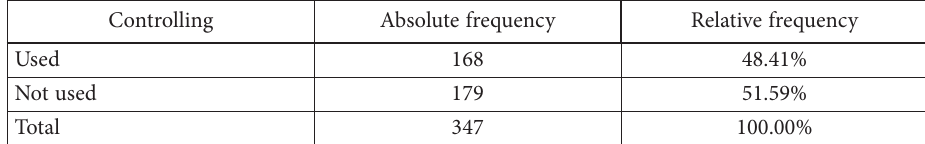
Table 2. Frequency table – distribution of enterprises in terms of the use of controlling Controlling Absolute frequency Relative frequency Used 168 48.41% Not used 179